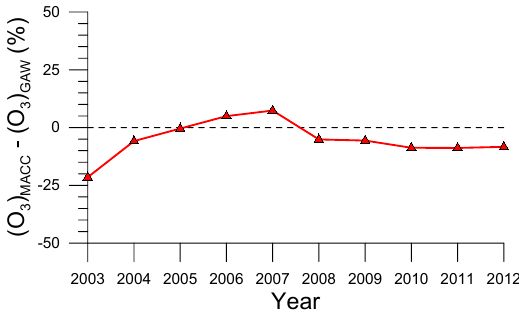
Figure 12. Annual averaged normalised median bias (%) of the MACC ozone reanalysis mixing ratios relative to the Global Atmo- sphere Watch (GAW) surface observations for the years 2003–2012.